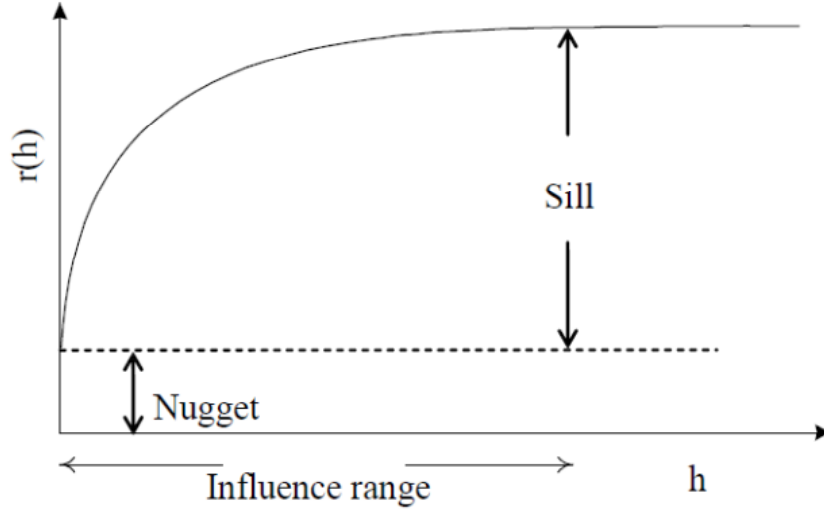
Figure 1. A diagram of the theoretical semivariogram.